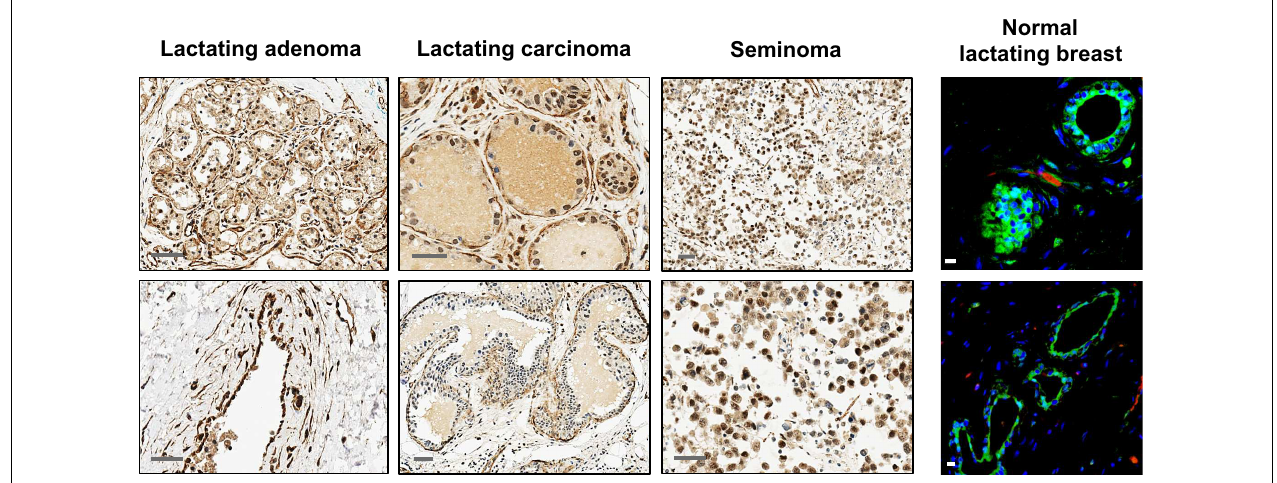
compare the respective tissue with the normal resting breast and red stars with the normal lactating breast. Normal human resting breast: N = 2; normal human lactating breast: N = 6; lactating breast adenomas: N = 7; lactating breast carcinomas: N = 3; pregnancy-associated breast cancer (PABC): N = 1. P values for overall levels of expression were determined with OLS regression separately for each location and comparison tissue, and are shown as: 0.05 < ≤ 0.1; 0.01 < * ≤ 0.05; and 0.001 < ** ≤ 0.01.